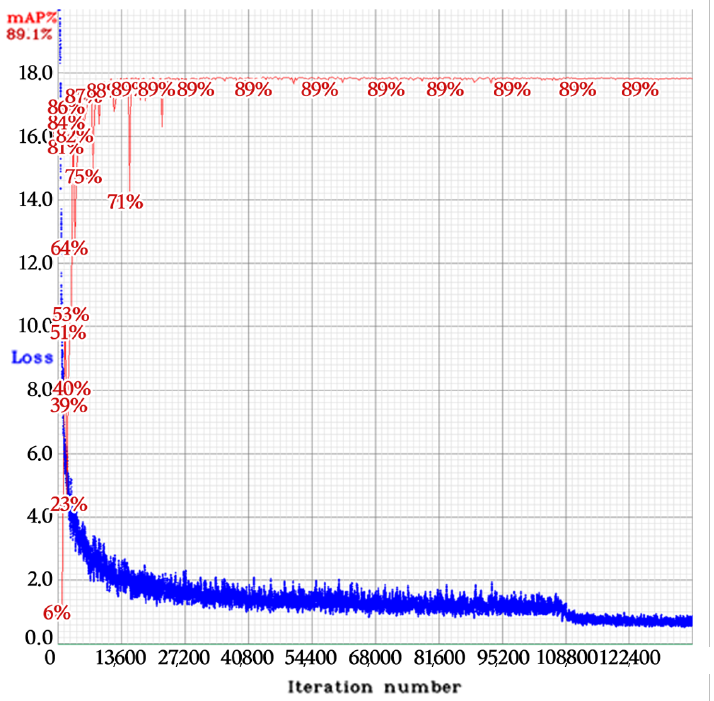
Figure 10. Training loss (blue) and mAP @ 0.5 (red) of the LPC detector in phase 2. Table 5. Successfully detected smallest LPs in ascending order of their